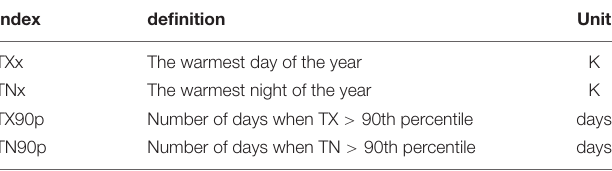
TABLE 2 | Temperature indices used in this